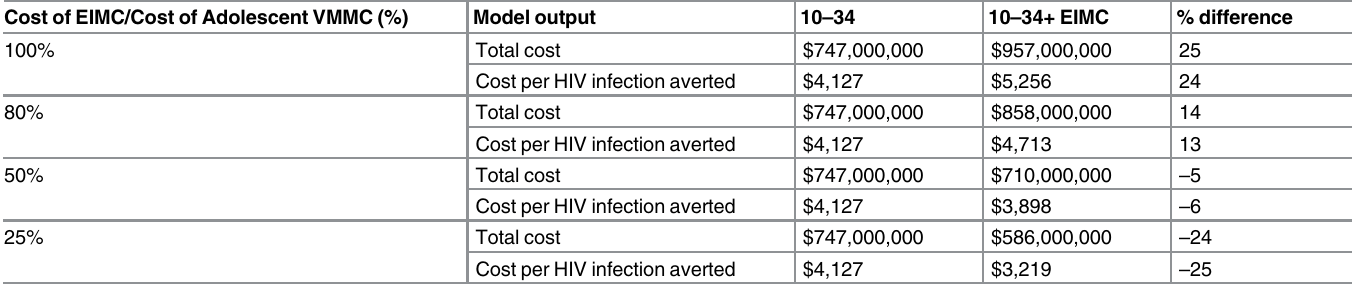
Table 4. Cost and Cost-effectiveness of Adding